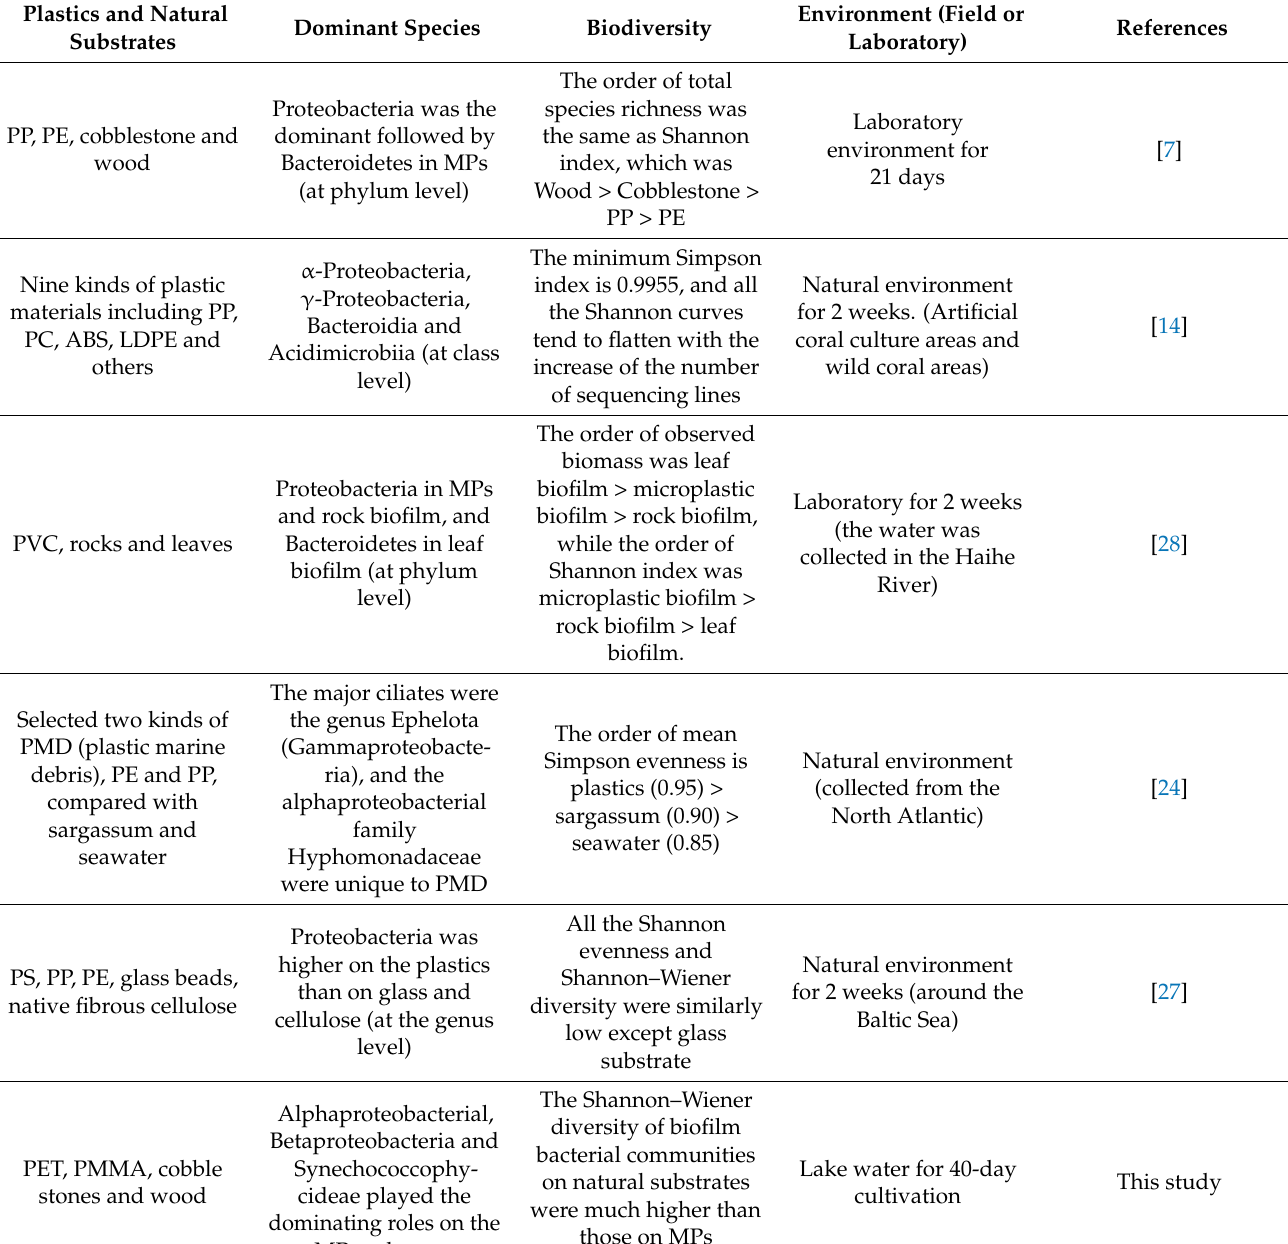
Table 2. Comparison of biofilms on plastics and natural